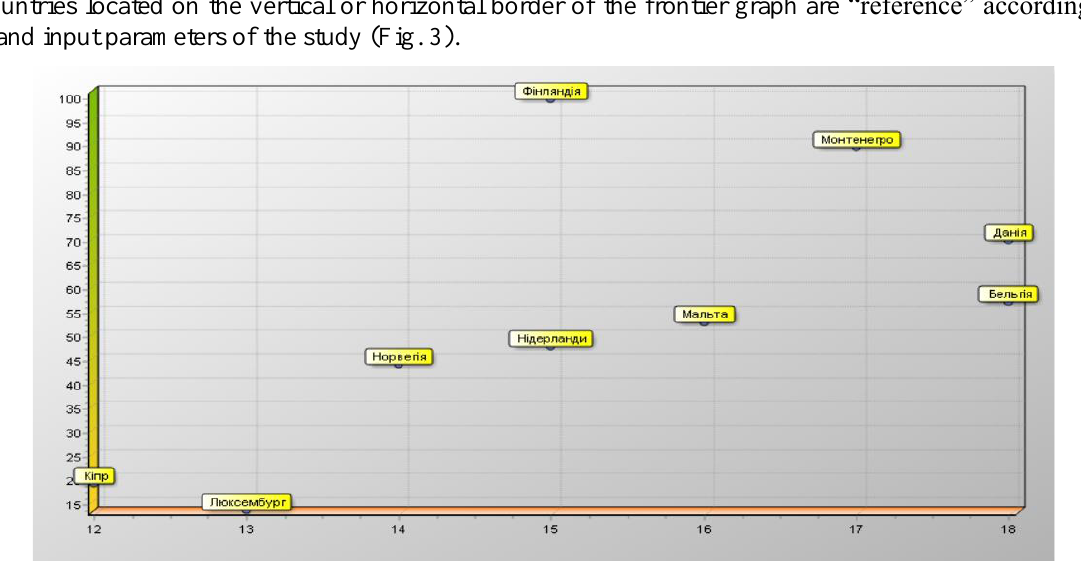
Figure 3. Graph of countries’ efficiency (for the 1 st